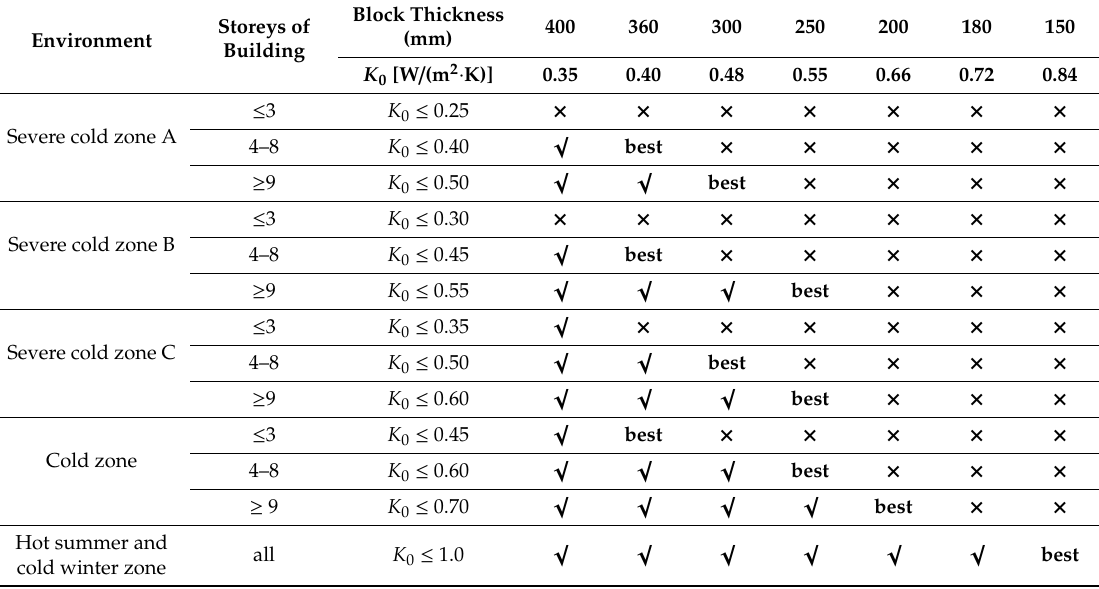
Table 7. Proposed heat transfer coe ffi cient of AAC self-insulation block walls and applied